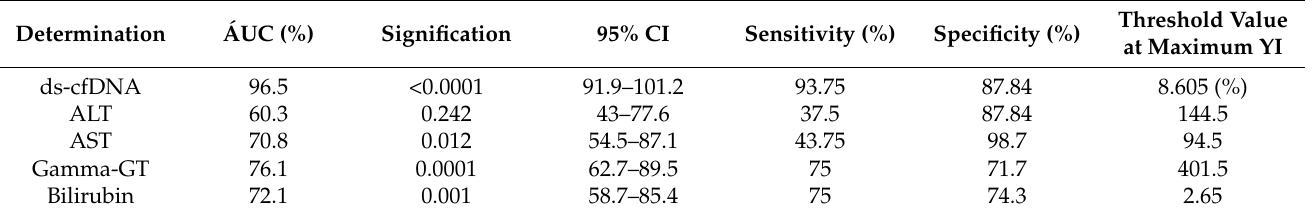
Table 4. Youden index diagnostic sensitivity and specificity from receiver operator characteristic (ROC) curve in rejection versus stable